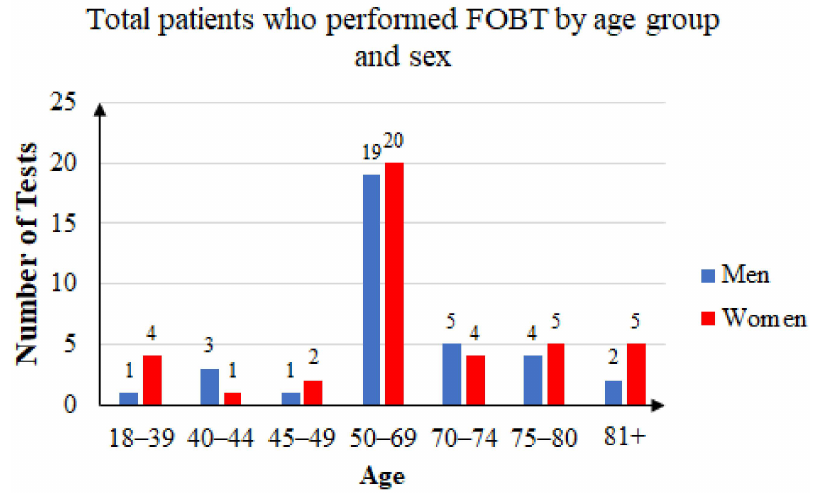
Figure 4. Three years’ statistics: total of recommended tests by age group and sex.